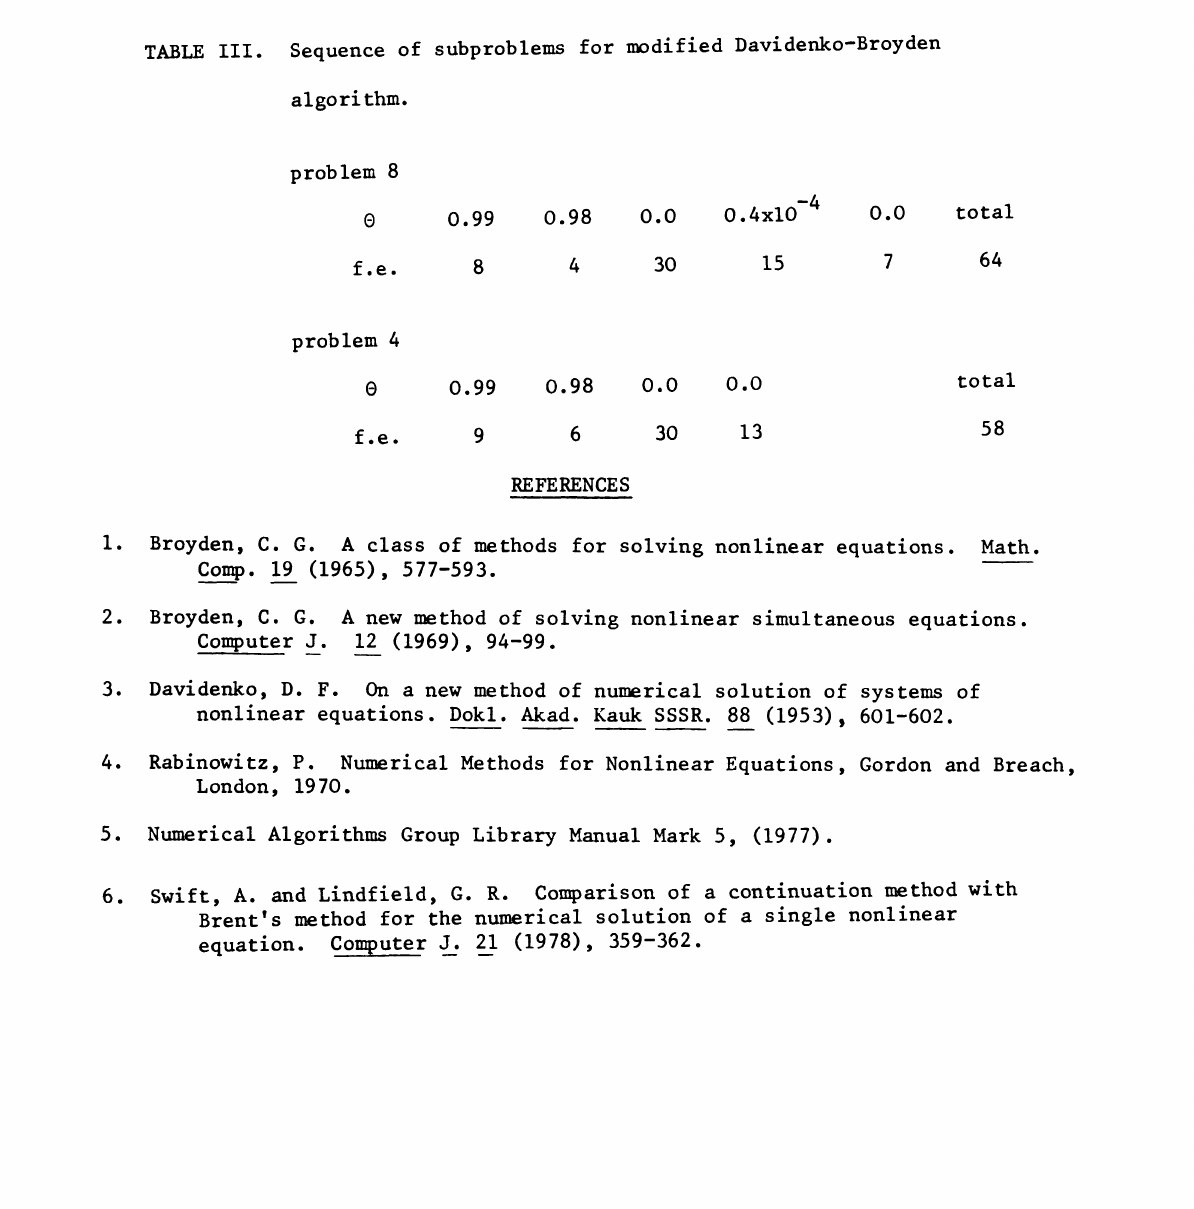
TABLE III. Sequence of subproblems for modified Davidenko-Broyden